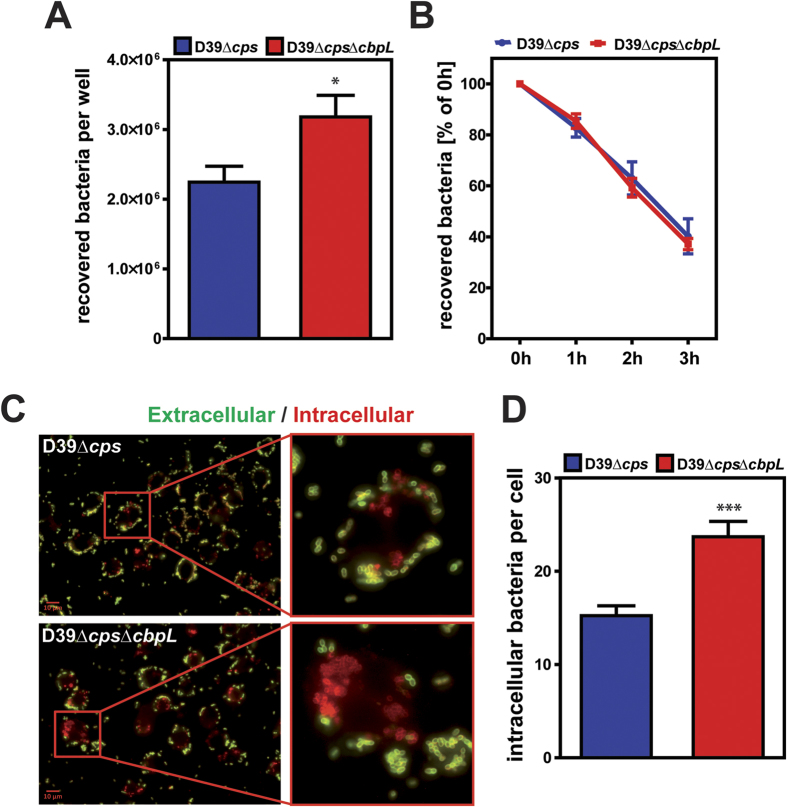
Effect of CbpL deficiency on uptake of S. pneumoniae D39Δcps by professional phagocytes.(A) J774 murine macrophages were infected for 30 min with non-encapsulated D39Δcps or its isogenic cbpL-mutant. The multiplicity of infection was 50 bacteria per cell. The recovery of intracellular pneumococcal survivors was quantified by applying the antibiotic protection and plating the bacteria on blood agar plates. Experiments were done at least three times in triplicate and data represent the mean of recovered bacteria per well ± SEM. *P < 0.05. (B) Intracellular survival of pneumococci. Infected J774 cells were lysed either immediately after 30 min infection and post antibiotics treatment (t = 0) or one, two or three hours post antibiotic treatment. Experiments were done at least three times in duplicate and data represent the mean of recovered bacteria per well ± SEM. (C) Immunofluorescence microscopy of pneumococci attached (green) to J774 macrophages and phagocytized, intracellular pneumococci (red) 30 min post infection. Attached bacteria were stained with goat anti-rabbit Alexa Fluor 488 (green), while intracellular bacteria were stained with goat anti-rabbit Alexa Fluor 568 (red) after using rabbit anti-pneumococcal polyclonal antibodies as the first antibody. Intracellular bacteria were stained post Triton X-100 treatment to permeabilize macrophages. (D) Number of phagozytosed pneumococci (mean ± SEM) per macrophage as determined by counting intracellular pneumococci in at least 50 macrophages of double immunofluorescence microscopic samples. ***P < 0.001.